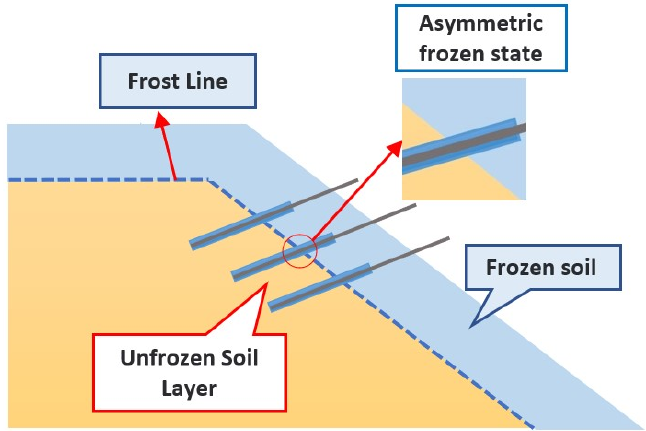
Figure 1. Schematic diagram of asymmetric freezing of a bolt.